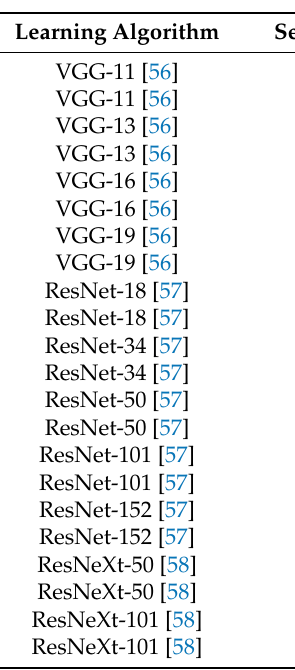
Figure 3. Learning Rate. ( a ) DPN-131 [60]; ( b ) ECA-ResNet-101 [61]; ( c ) IG-ResNet101 [62]; ( d ) SWSL-ResRet101 [63]. Table 5. Binary classification of malignant skin